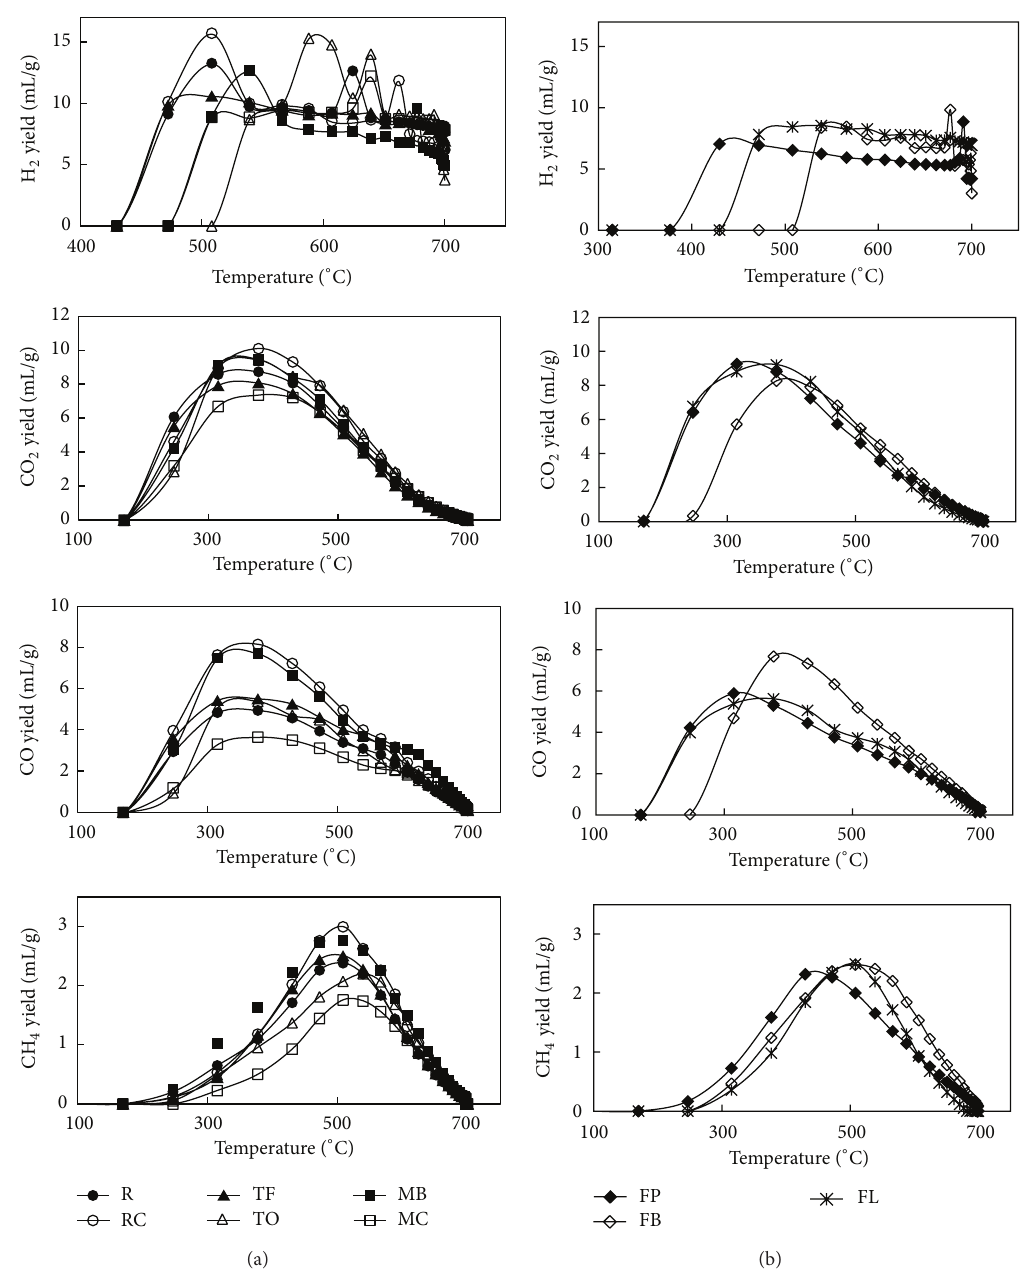
Figure 5: Evolution profiles of individual gaseous products from pyrolysis of (a) NHG composts and (b) HG composts.